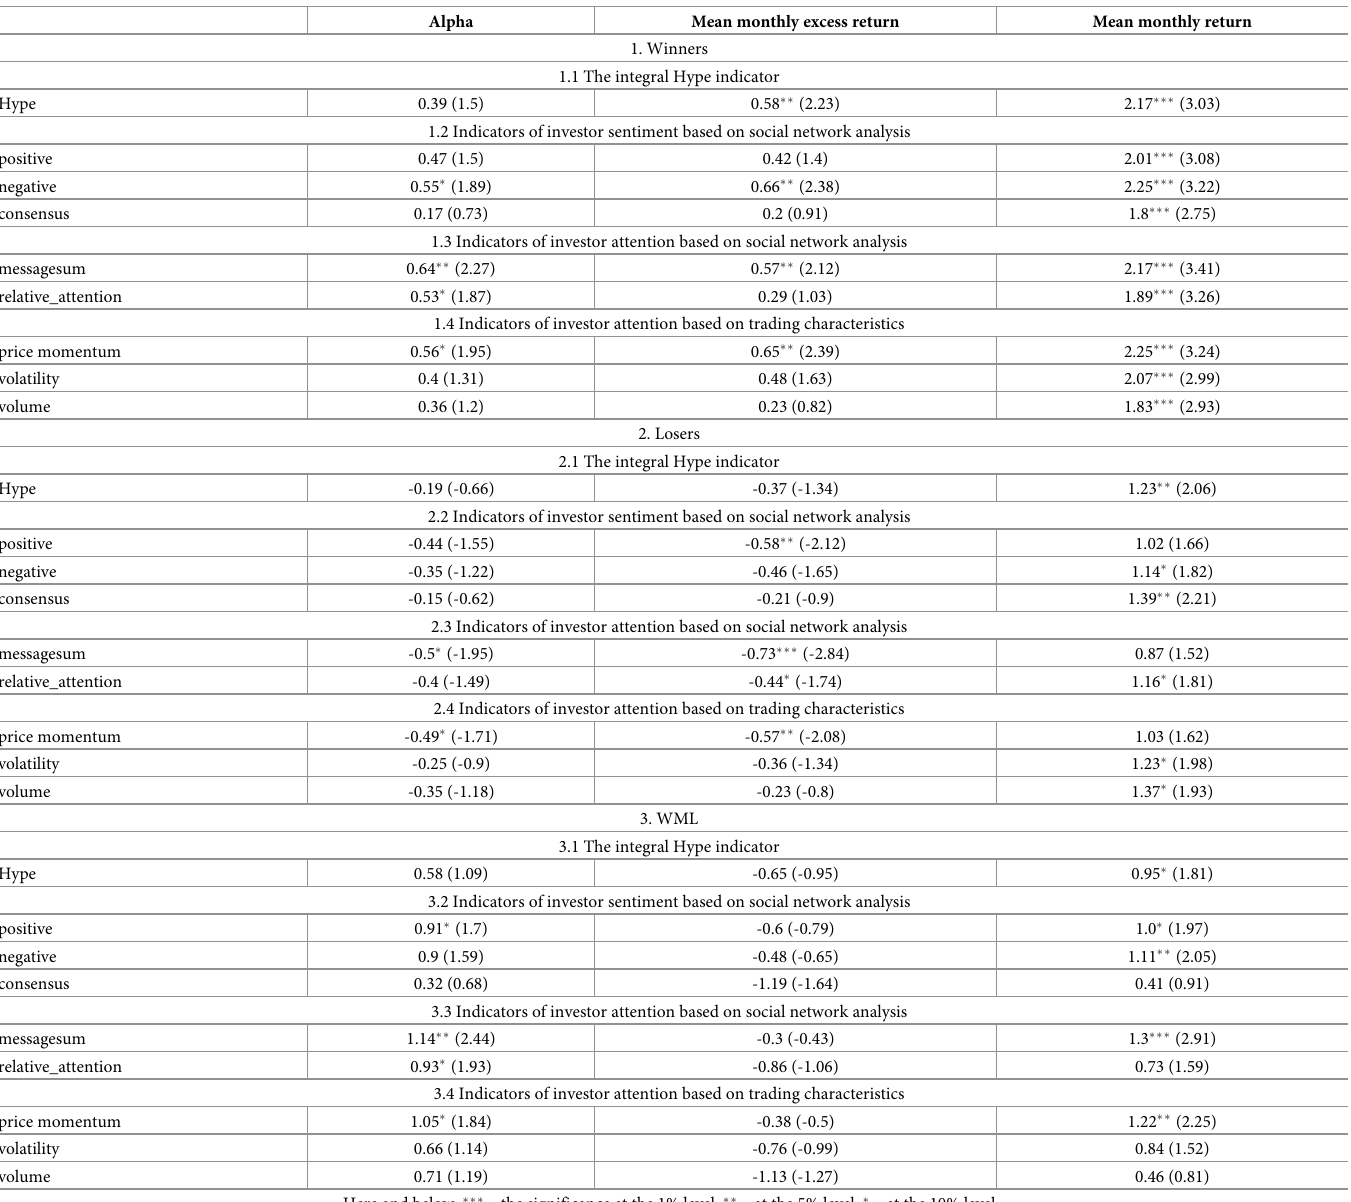
Table 5. The performance of the nine portfolios over a short period (1